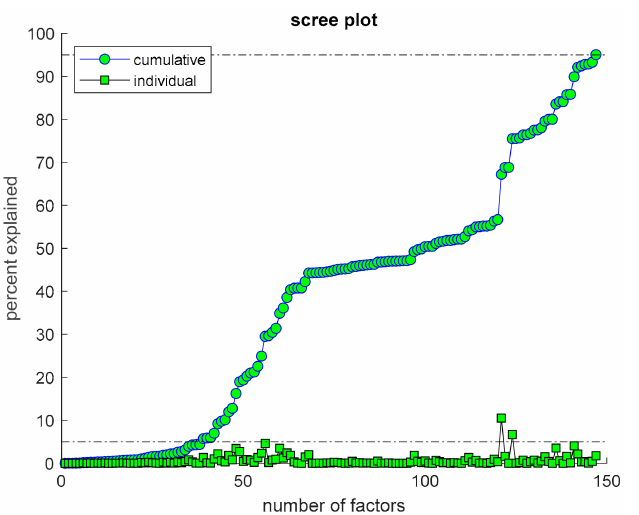
Figure 3. A scree plot was used to determine the point where centralization values dropped as the cutoff point between high and low values [27]. The plot shows that the first significant drop of centralization values is at